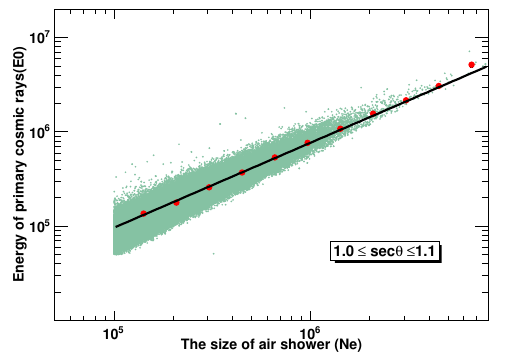
Figure 6. Scatter plots of the primary energy E 0 and the esti- mated shower size N e of (P + He)-like events based on (EPOS- LHC + He-poor) model with sec θ